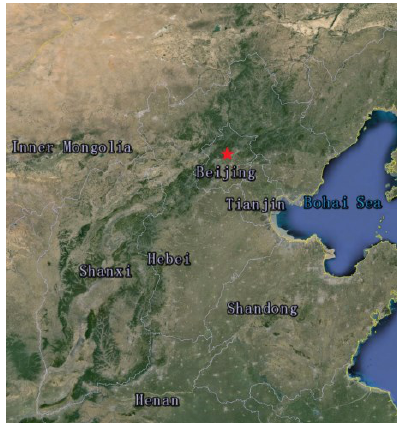
Figure 1. Key regions in China where restrictive measures were implemented. The red star represents the Beijing measurement site.